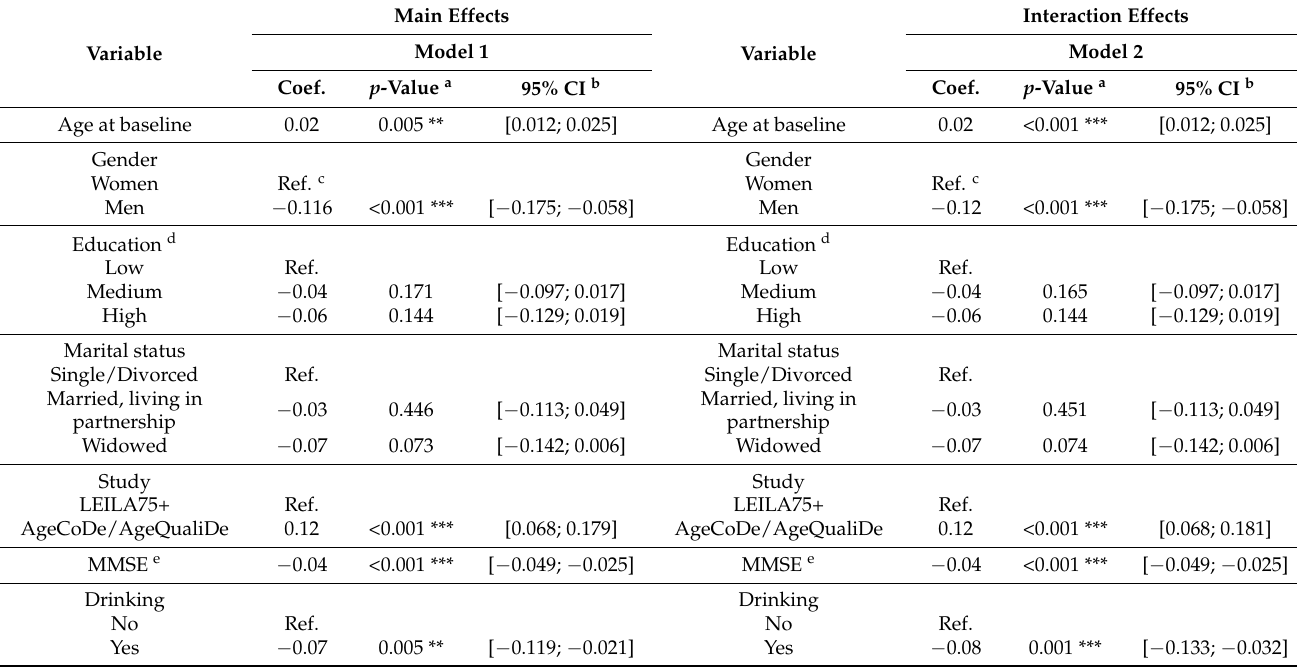
Table 3. Linear mixed-effects regression model with the harmonized depression scale (n =